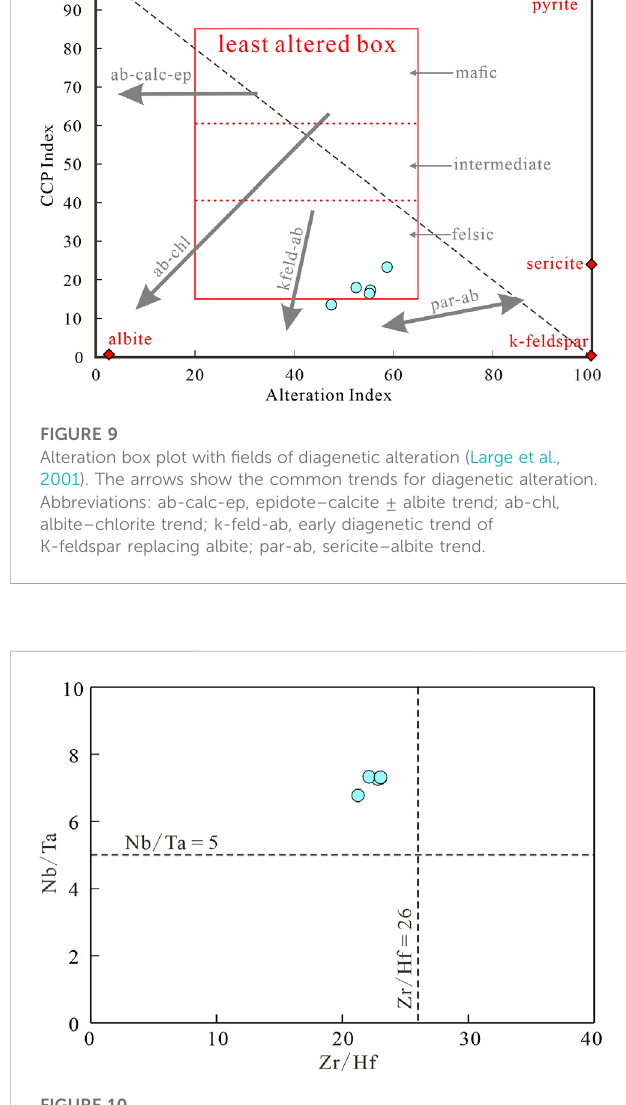
FIGURE 10 Nb/Ta versus Zr/Hf diagram showing the degree of magmatic